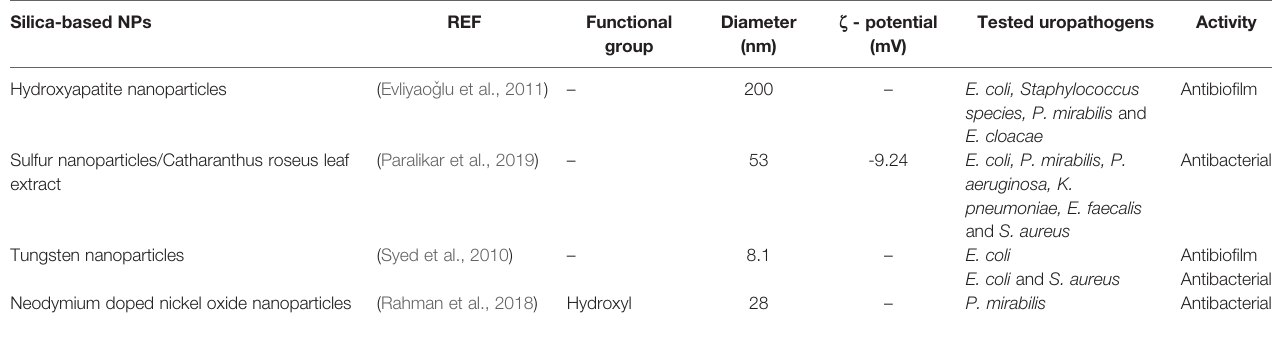
TABLE 10 | Physicochemical characteristics of inorganic